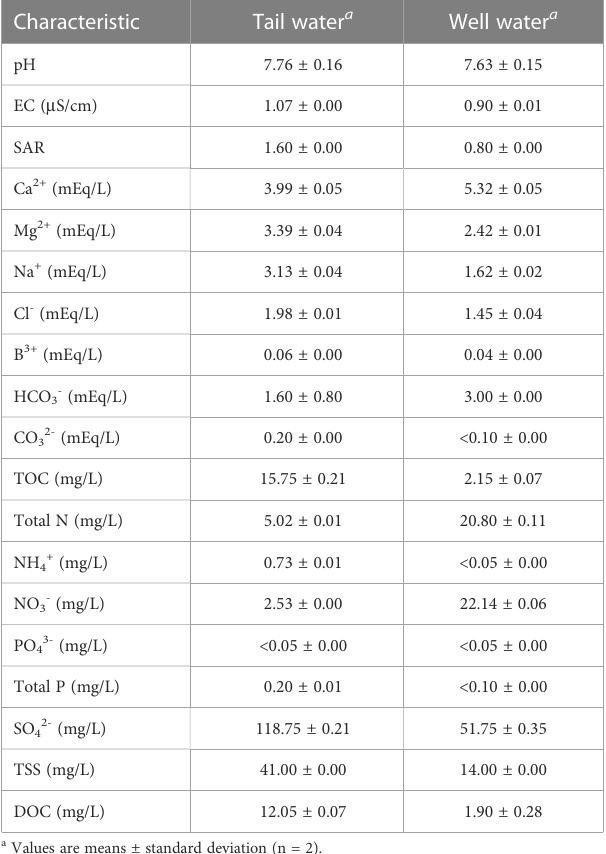
TABLE 1 Water quality chemical analysis for tail water and well water collected from a single farm in the Salinas Valley.